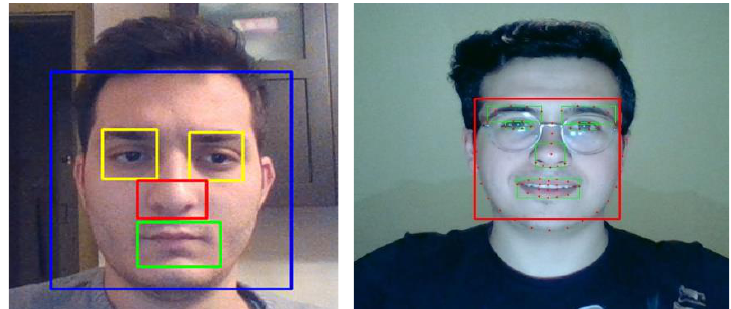
Fig. 6. Facial feature extraction to detect a person’s mouth, nose and eyes; the face on the right illustrates the detection of eyebrows and the jawline as well.